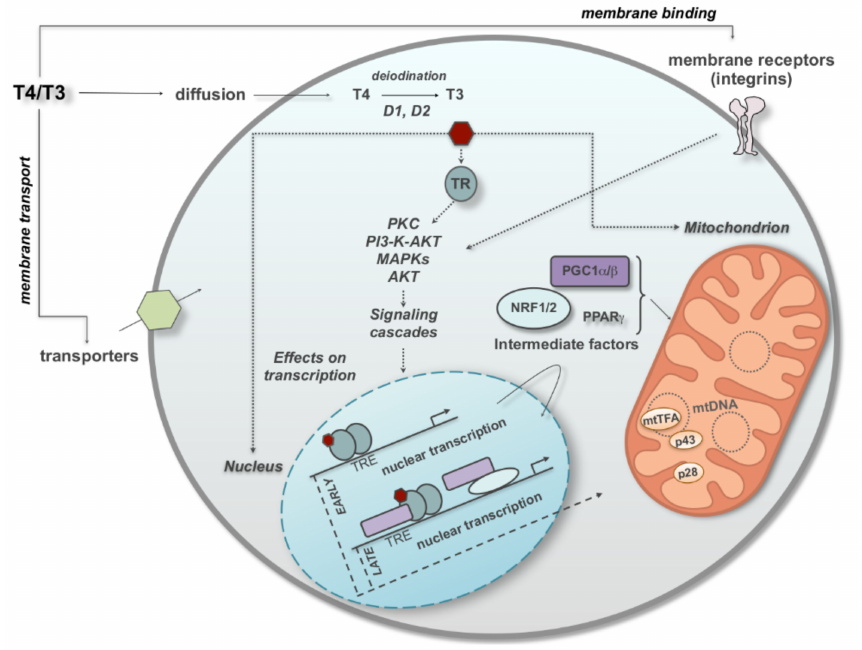
Figure 1. Schematic summary of the main cellular pathways through which TH regulate mito- chondrial functions. TH (T4/T3) move from outside the plasma membrane into the cytoplasm (trough passive diffusion or active transport) or bind to surface receptor such as integrin α vb3. In the cytoplasm, deiodination allows the conversion of T4 into T3 by DIO1 or DIO2 action, and T3 can